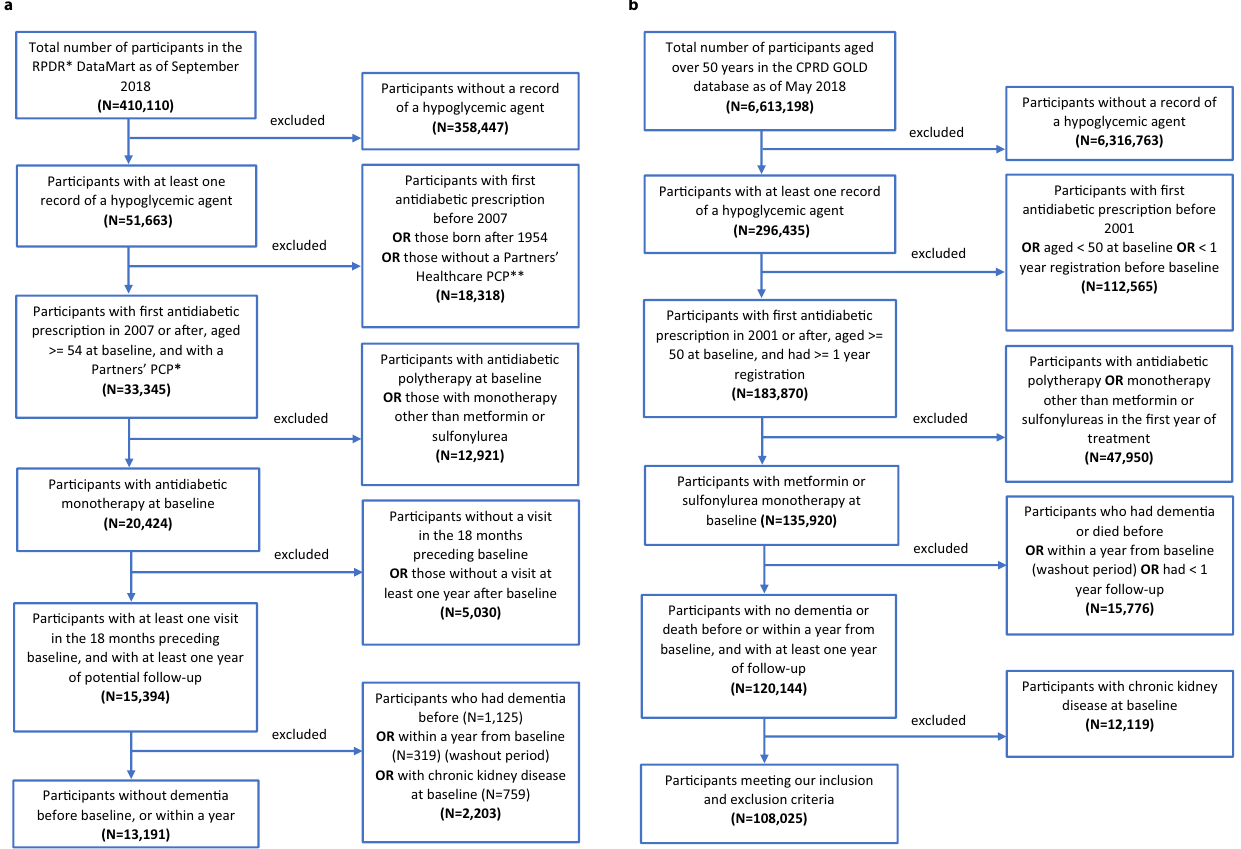
Fig.1|ConsortDiagramsforUSRPDRandUKCPRD.a FlowchartofinclusionandexclusioncriteriaofstudypopulationinRPDR. b Flowchartofinclusionandexclusion criteria of study population in